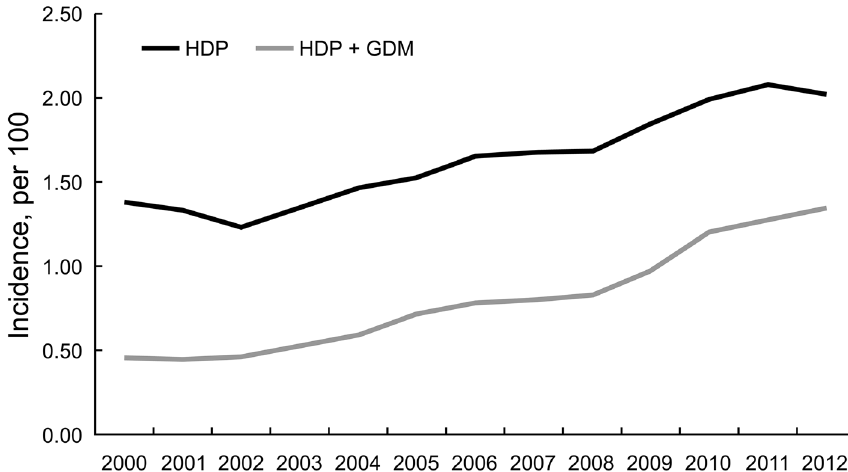
Figure 1. Twelve-year trend of incidence (per 100) of hypertensive disorders of pregnancy (HDP) and gestational diabetes mellitus (GDM) in pregnancy women.